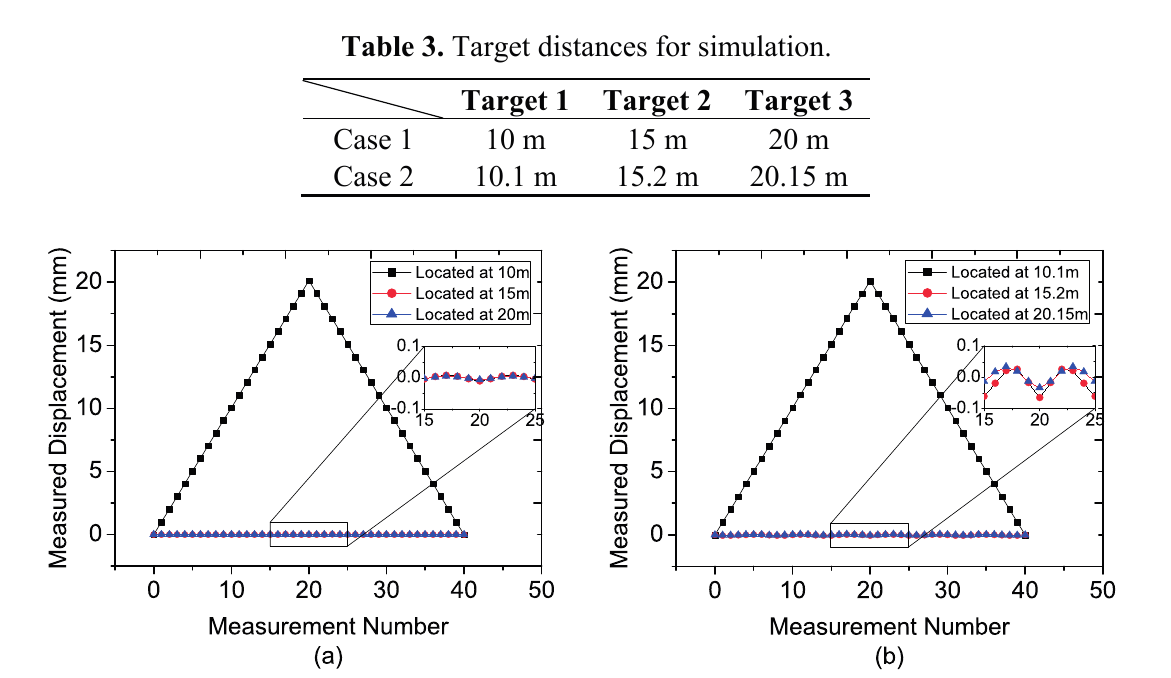
Table 3. Target distances for simulation.